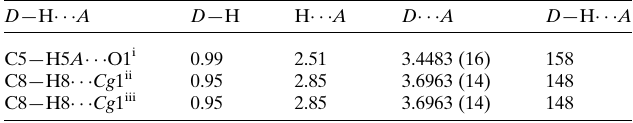
Table 1 Hydrogen-bond geometry (A˚ , (cid:3) ).